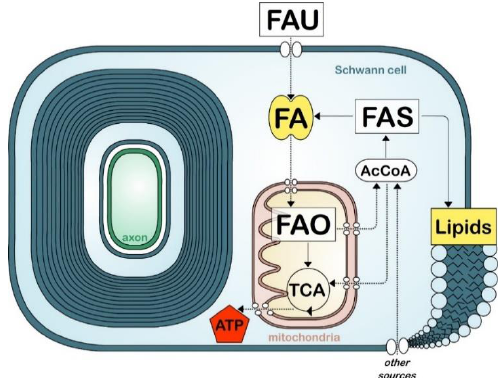
Figure 2. Simplified view of fatty acid metabolism in myelinating cells. Fatty acid (FA) uptake (FAU), synthesis (FAS), and oxidation (FAO). Tricarboxylic acid cycle (TCA). Acetyl-coA (AcCoA). Other sources include glucose and amino acids.